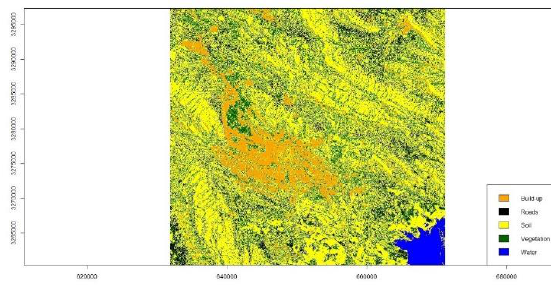
Figure 5. Image classification using Random Forest classifier within R programming